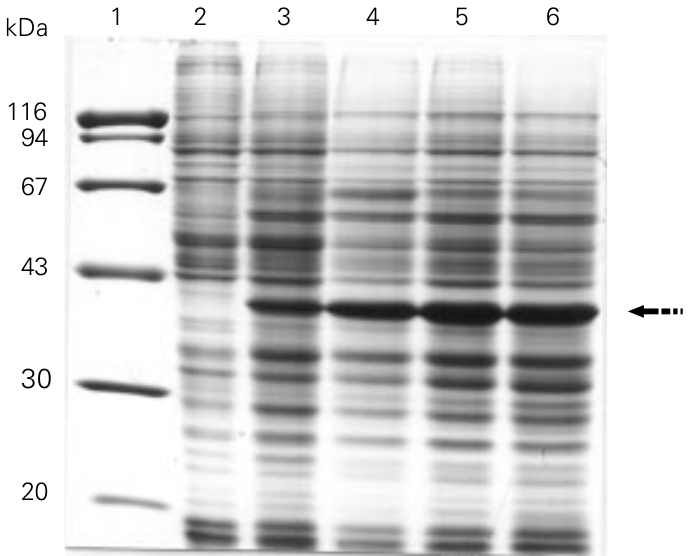
Figure 2 - SDS-PAGE (0.1% SDS-10% polyacrylamide, Coo- massie blue stained) of whole lysates of Sf9 cells infected with recombinant baculovirus for the large-scale expression of the catalytic domain of chicken PARP (72 h of infection, 10 5 cells/ slot). Lane 1 , Molecular mass markers ((cid:223)-galactosidase, 116 kDa; phosphorylase b, 94 kDa; serum albumin, 67 kDa; ovalbu- min, 43 kDa; carbonic anhydrase, 30 kDa; trypsin inhibitor, 20 kDa); lane 2 , non-infected Sf9; lane 3 , Sf9 cells cultivated in spinner flasks; lanes 4 to 6 , three batches of Sf9 cells cultivated in Erlenmeyer flasks. The arrow indicates the position of the band corresponding to the recombinant 40-kDa catalytic domain of chicken